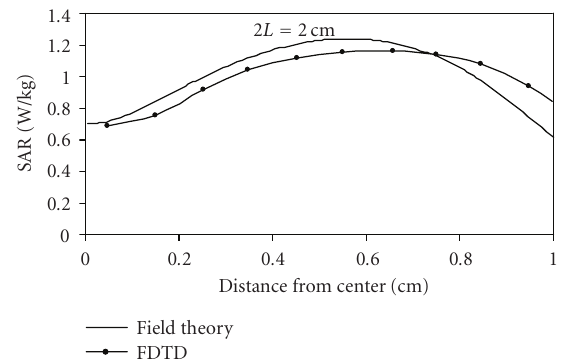
Figure 4: SAR at surface of the tissue for the 2cm total length an- tenna.